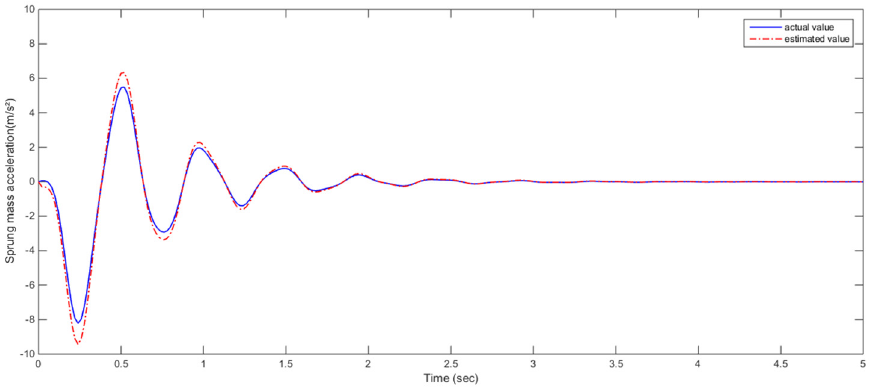
Figure 3. The step response of the actual and estimated sprung mass acceleration.